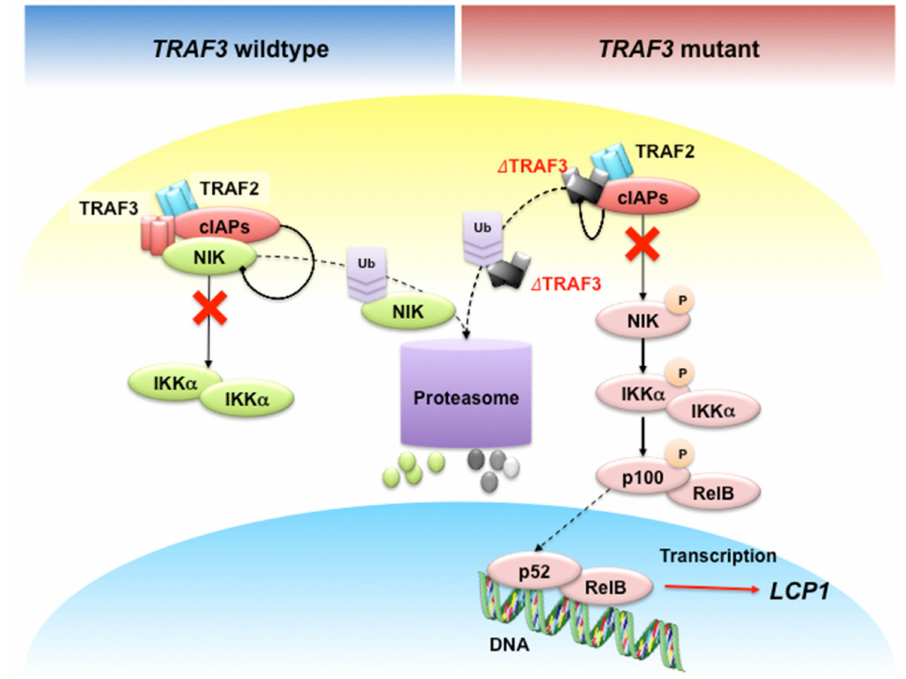
Figure 4. Constitutive NIK-driven NF- κ B activation without functional TRAF3 in MM. In normal physiological conditions, TRAF3-TRAF2 interaction recruits the E3 ligases cIAPs to NIK to induce K48 ubiquitination, followed by proteasome-dependent degradation of NIK. In TRAF3 -mutant MM cells, mutations in the TRAF or MATH domain of TRAF3 result in ∆ TRAF3 proteins that are unable to interact with TRAF2 and NIK, thus stabilizing NIK to activate non-canonical NF- κ B signaling. Arrows with triangle heads indicate activation, whereas arrows with rhomboid heads indicate inactivation / inhibition; directinteractionsareindicatedbysolidlines,